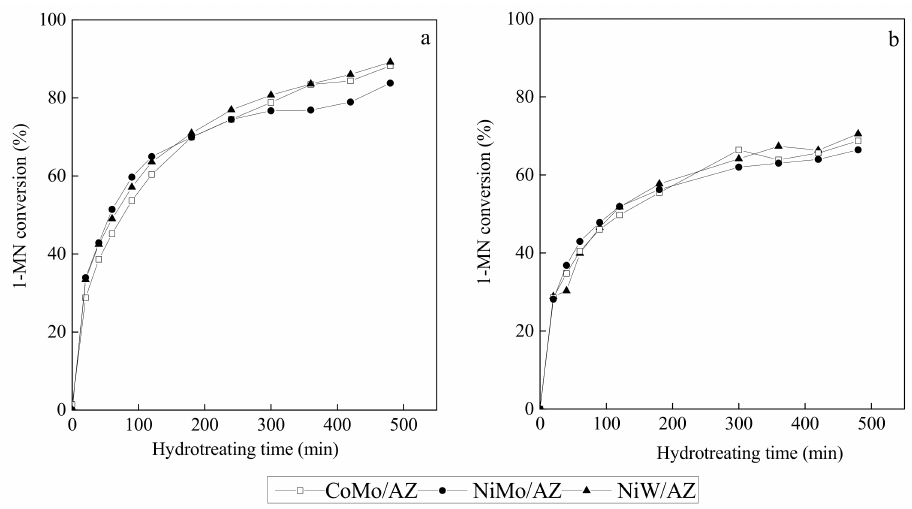
Figure 12. Hydrogenation of 1-MN with time on stream (reaction conditions: the same as the conditions in Figure 8). ( a ) without N compounds; ( b ) with 300 ppmN